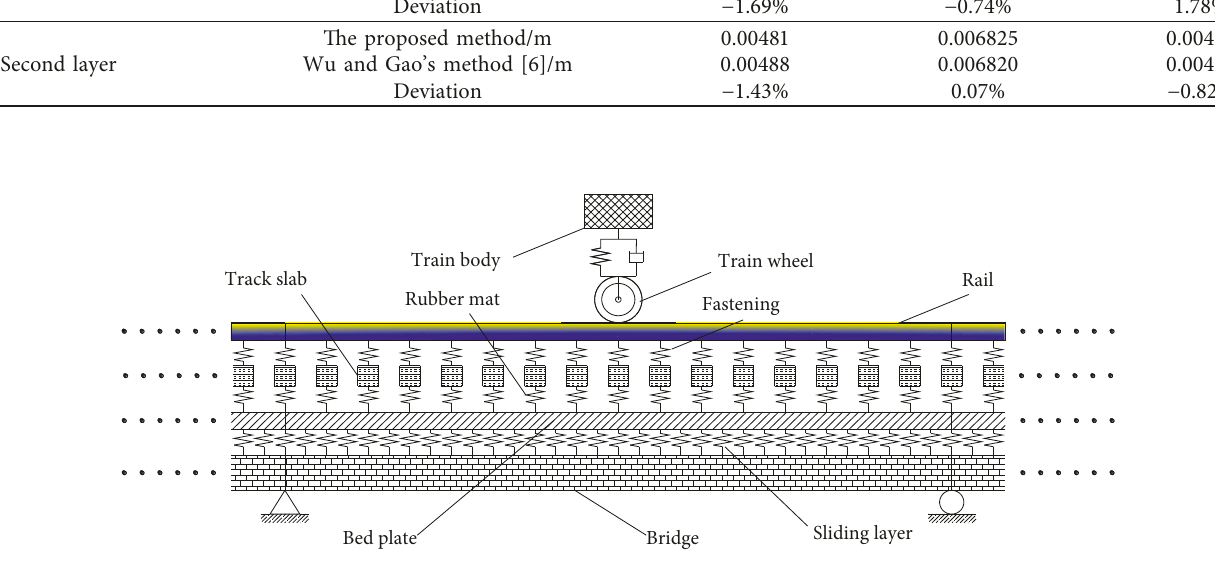
Figure 3: Simplified model of a railway line.